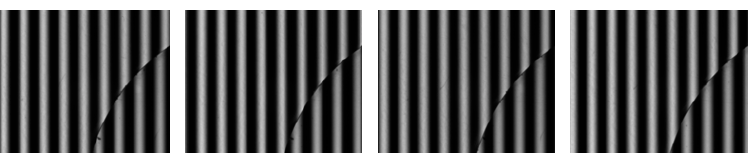
Figure 7. A fringe pattern from the disk experiment and its corresponding phase-shifting fringe patterns. Another complex object, a facial mask from opera, was measured, as shown in Figure 8. The same operations were performed as before to yield another 1000 experimental patterns.